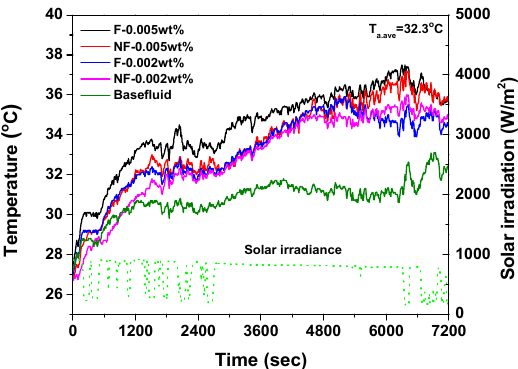
Figure 11. Variation of temperature with time for functionalized and nonfunctionalized MWCNT nanofluid.